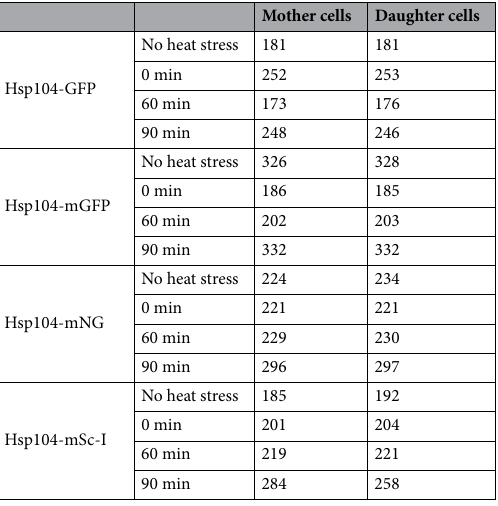
Table 3. Numbers of mother and daughter cells counted within one representative experiment illustrated in Fig. 3 to assess efficiency of heat-induced protein aggregate